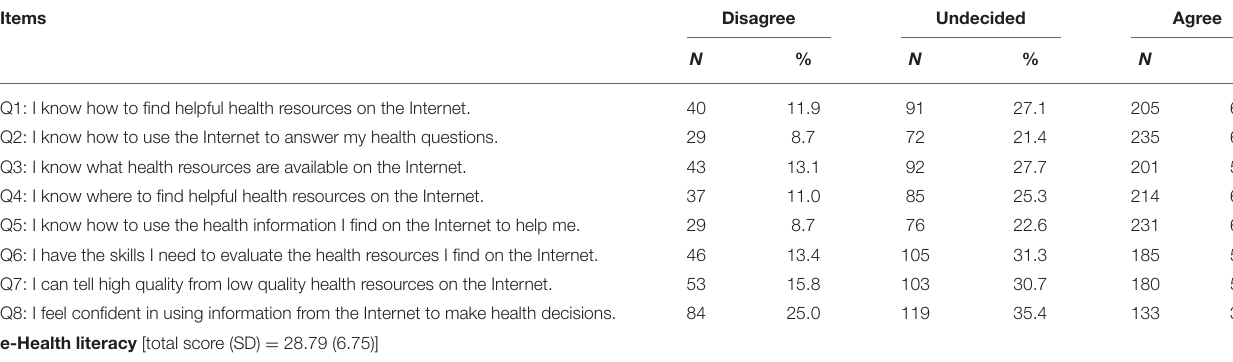
TABLE 2 | e-Health literacy of Saudi women ( N = 336).